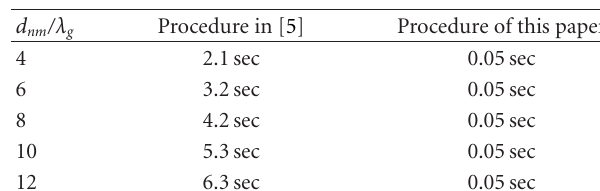
Table 1: Comparison between the computational times needed for the evaluation of the mutual coupling, θ =